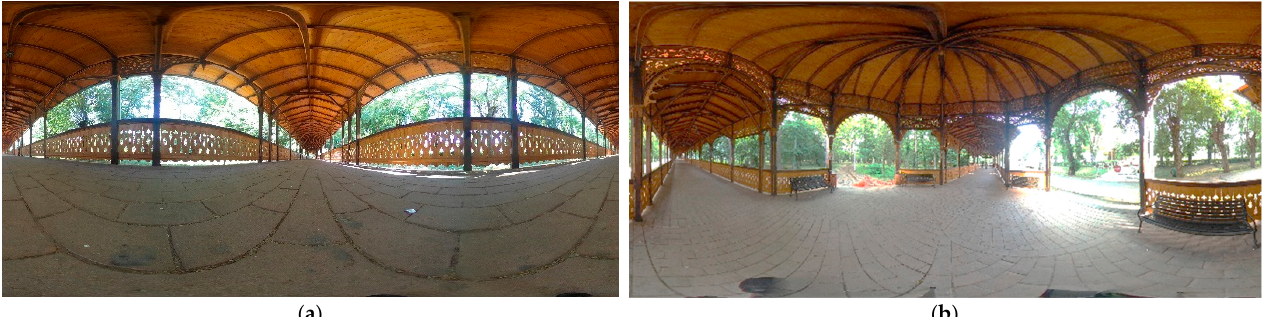
Figure 6. Survey by Ricoh Theta SC2: ground level ( a ) and tripod level ( b ).